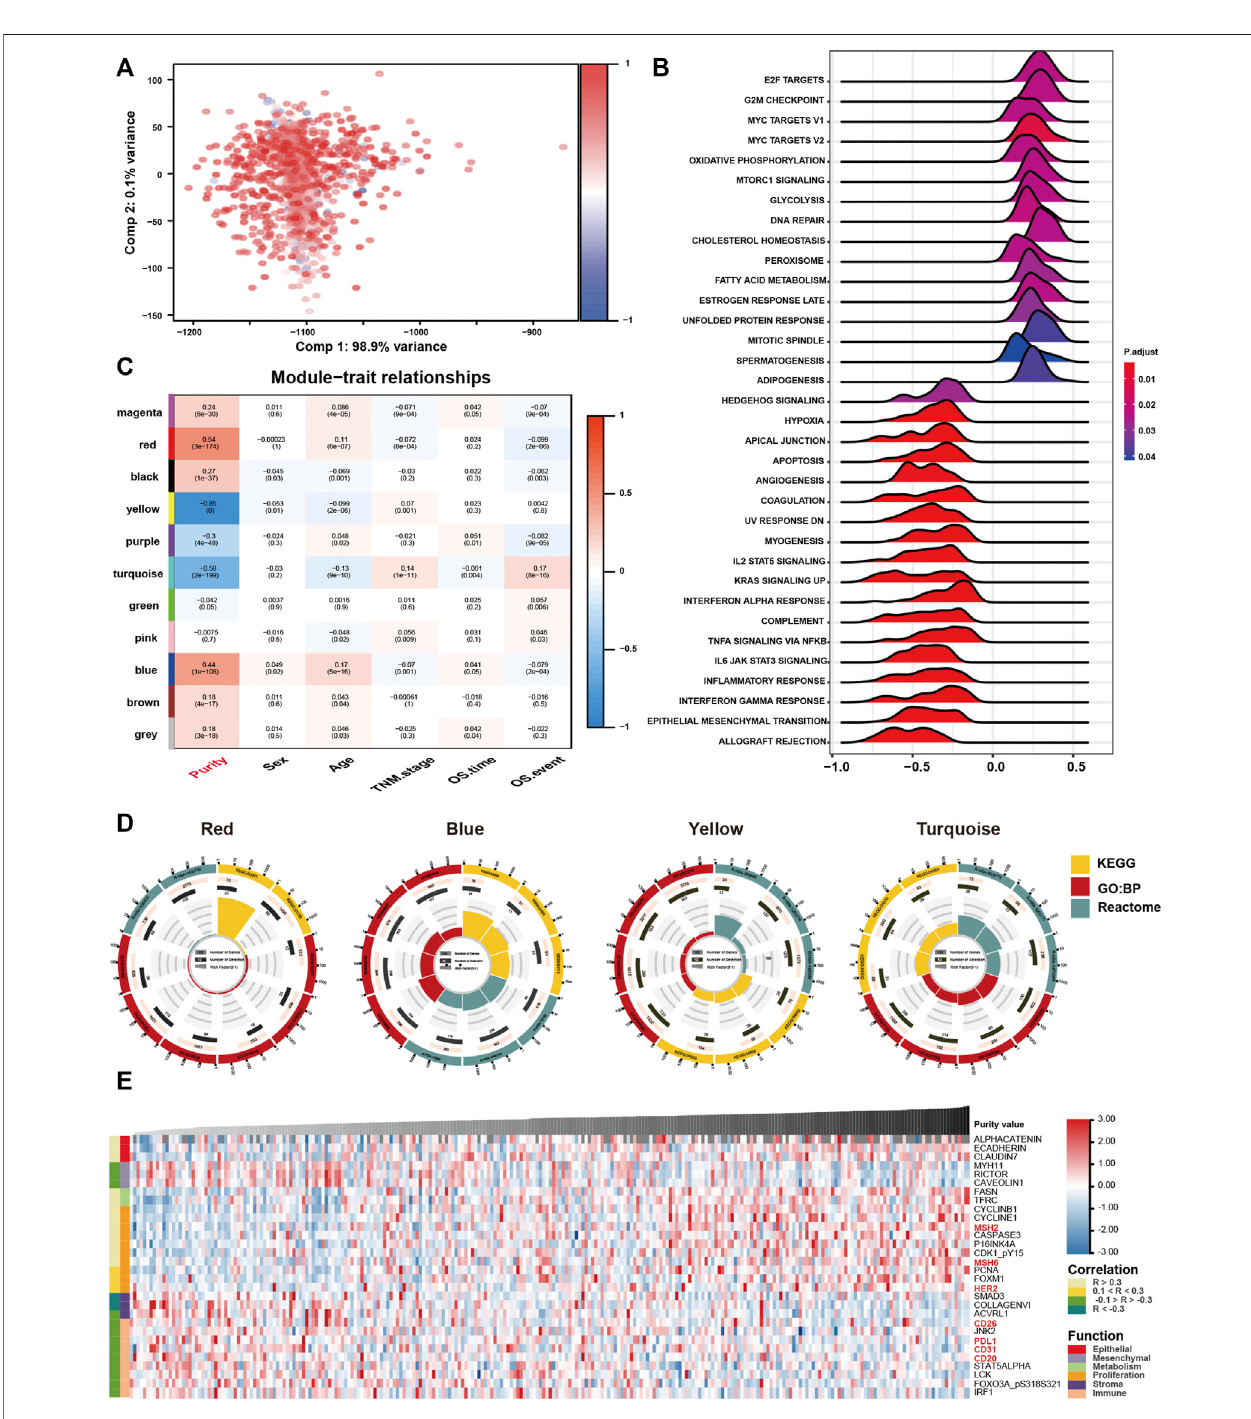
FIGURE 4 | Biological features of tumour purity in gastric cancer. (A) Principal component analysis score plot for the gene expression pro fi le underlying different puritylevels. (B) Genesetenrichmentanalysisassociatedwithpuritylevels. (C) Traitandmodulerelationshipanalysis.Eachrowcorrespondstoamoduleeigengeneand each column to a trait. The top number represents the biweight midcorrelation coef fi cient of each cell, and the corresponding p -values are mentioned in brackets. (D) Representative results of functional enrichment analysis for the yellow, blue, red and turquoise modules. (E) Heatmap of the reverse-phase protein arrays demonstrating purity-associated protein production. The coef fi cient was evaluated via Spearman correlation analysis.